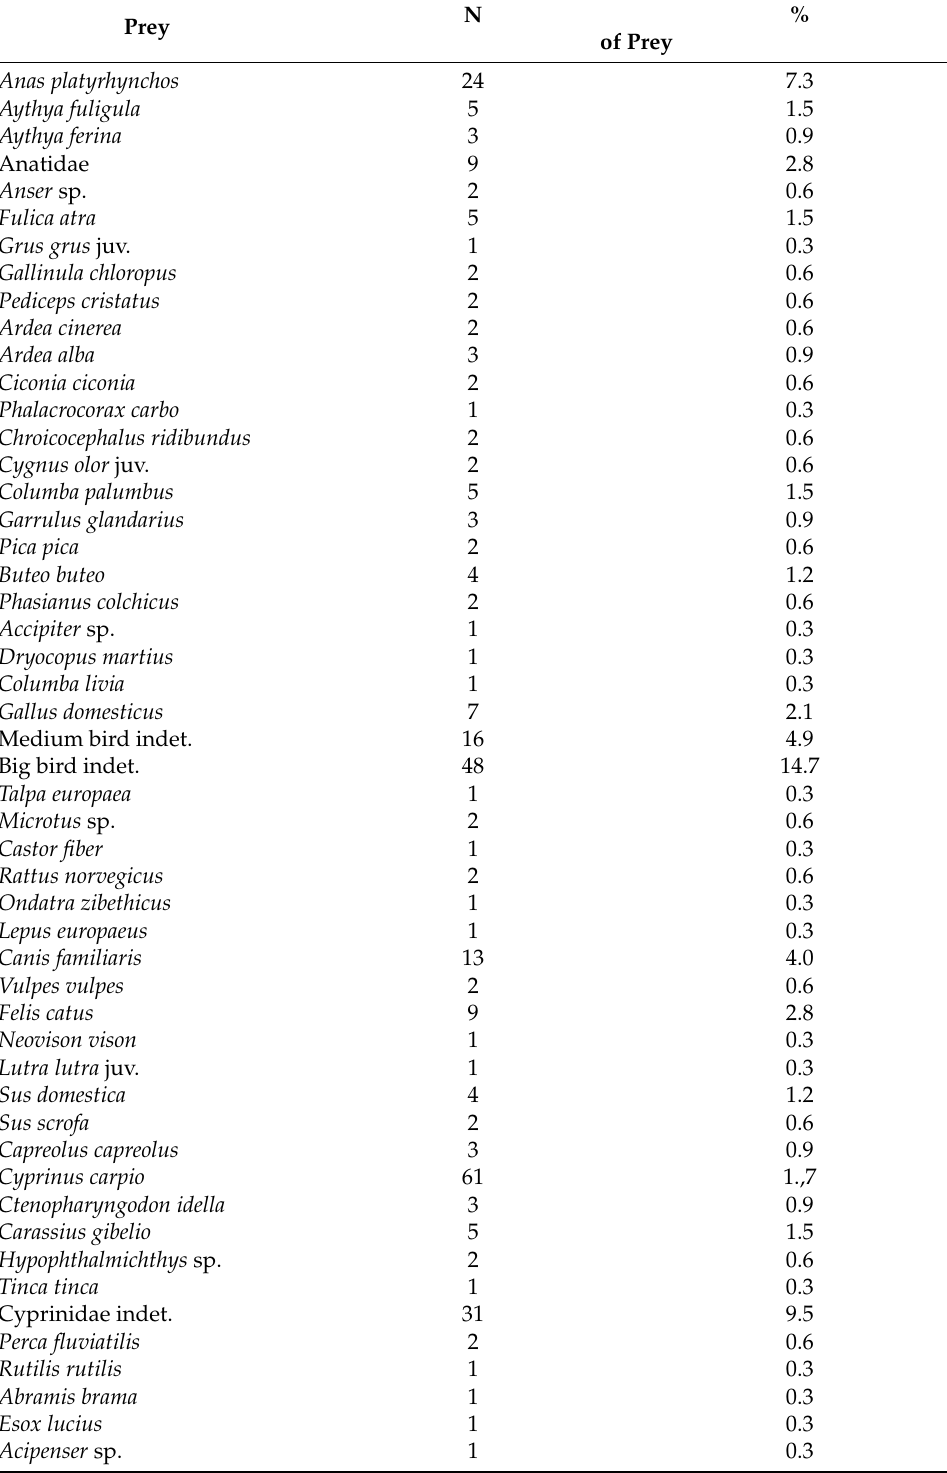
Table A1. The diet composition of the white-tailed eagle ( Haliaeetus albicilla ) in the breeding seasons 2008–2018 in the area of study (central Poland, vicinity of Rog ó w village, Experimental Forest Station of Warsaw University of Life Sciences), based on pellet analysis and prey remains collection. N – number of prey